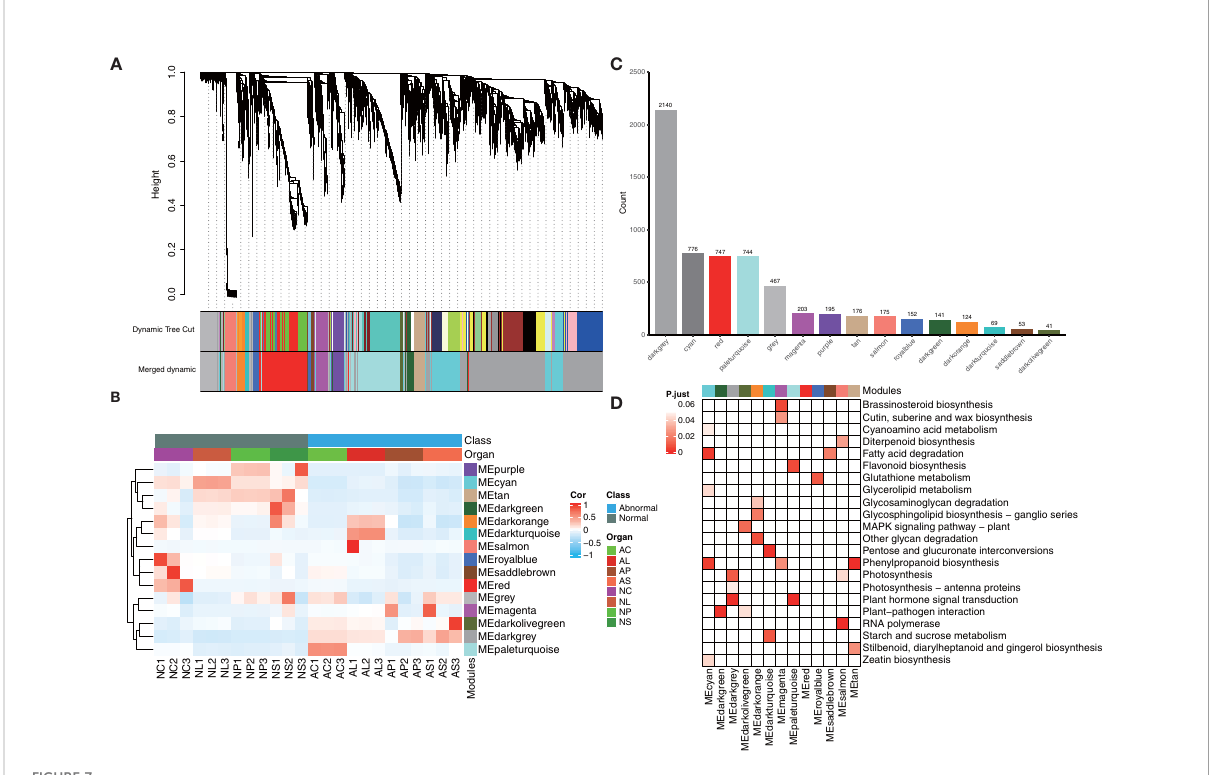
FIGURE 7 WGCNA analysis of 24 samples. (A) Hierarchical clustering tree showing the co-expression modules identi fi ed by WGCNA. (B) Heatmap of samples ’ expression patterns. The color of each cell at the row – column intersection indicates the expression level of the module. (C) Number of genes in different modules. (D) KEGG enrichment analysis of the WGCNA modules. All the KEGG terms with a q-value < 0.05 are